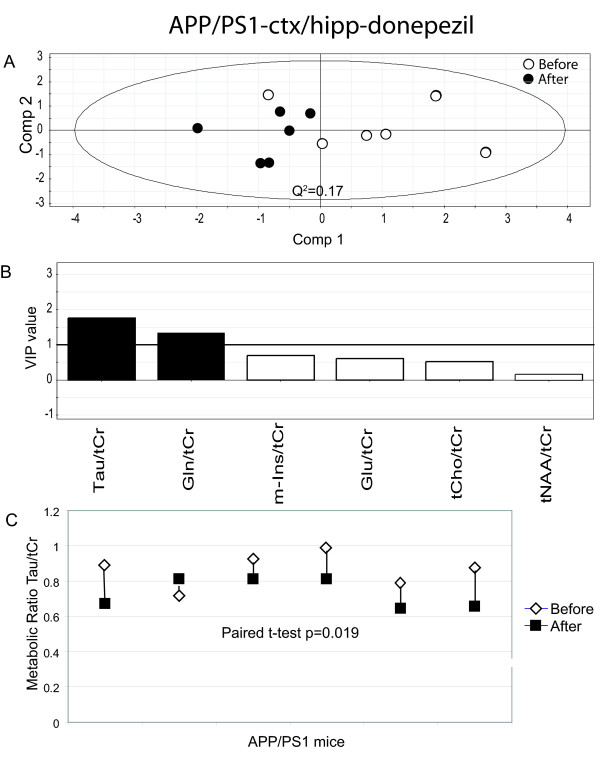
Results from the data analysis of donepezil treated APP/PS1 (cortex/hippocampus). (A) PLS-DA scatter plot which displays a clear separation between mice before and after donepezil treatment (white circles = before treatment and black circles after treatment). Each data point represents one mouse. A Q2-value above 0.05 indicates that the groups can be significantly distinguished along that component. (B) Metabolites which are important for the separation between groups in the PLS-DA model. VIP (variable of importance in the projection) values larger than 1 are relevant in explaining group differences (black bars) while metabolites with values below 1 have no significant impact (white bars). (C) The paired t-test shows a significant decrease in Tau, p = 0.019. White diamonds represent before treatment and black squares after treatment.